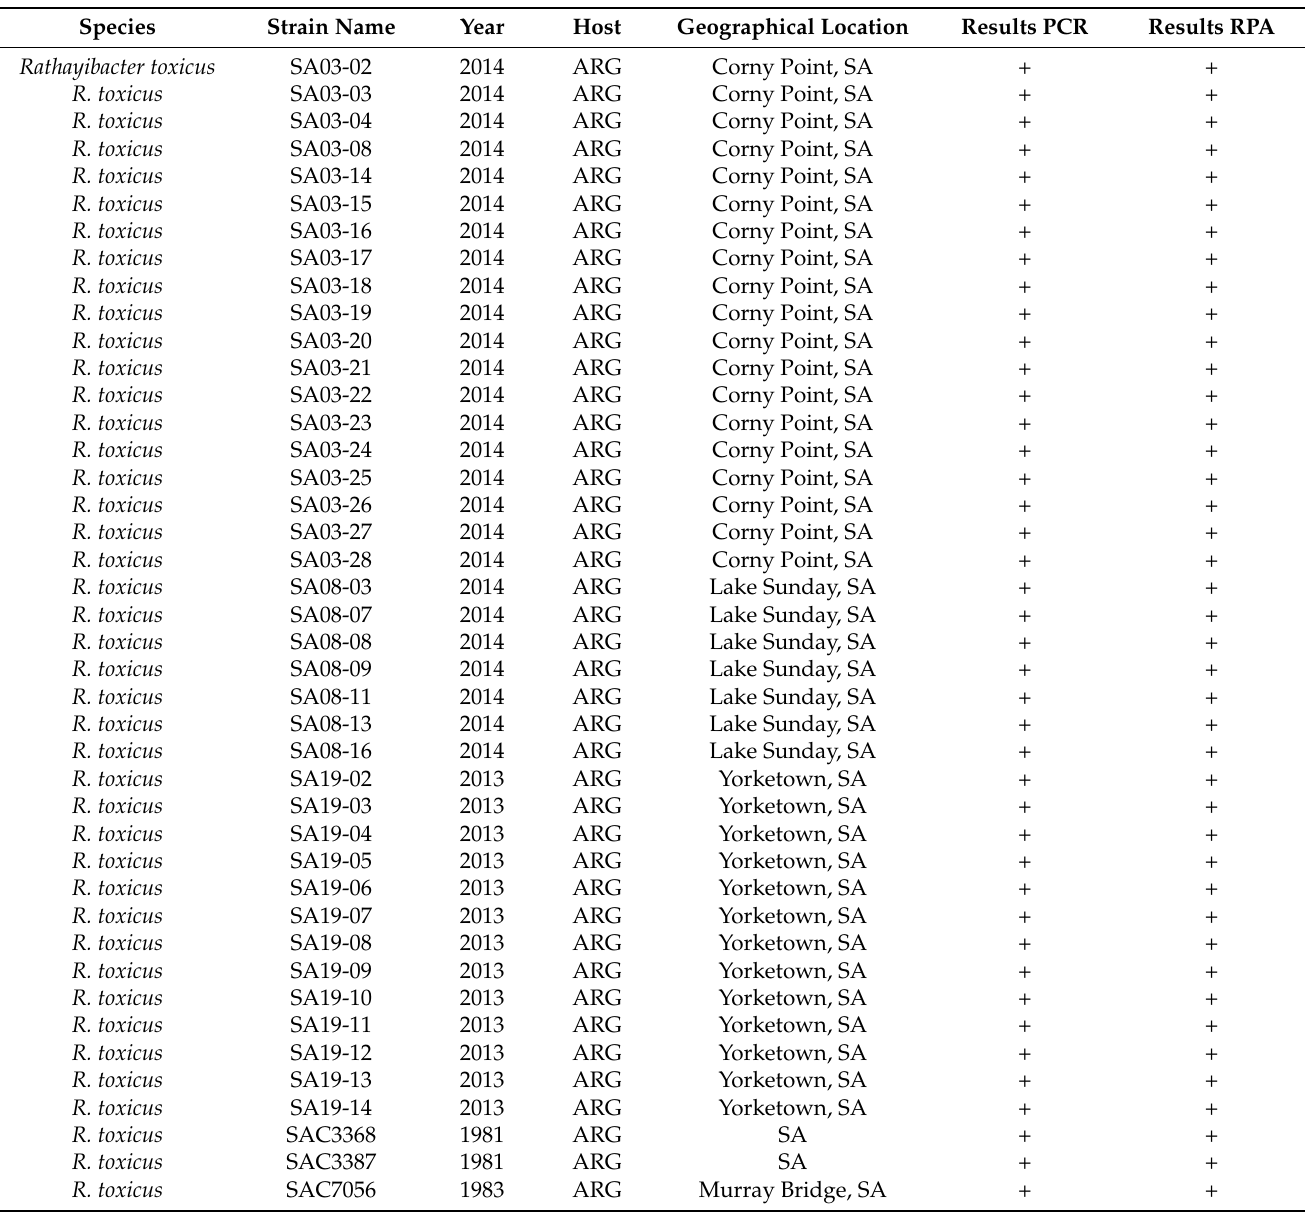
Table 1. Strains included in inclusivity and exclusivity panels to confirm specificity of the developed PCR and recombinase polymerase assays to specifically detect Rathayibacter toxicus .